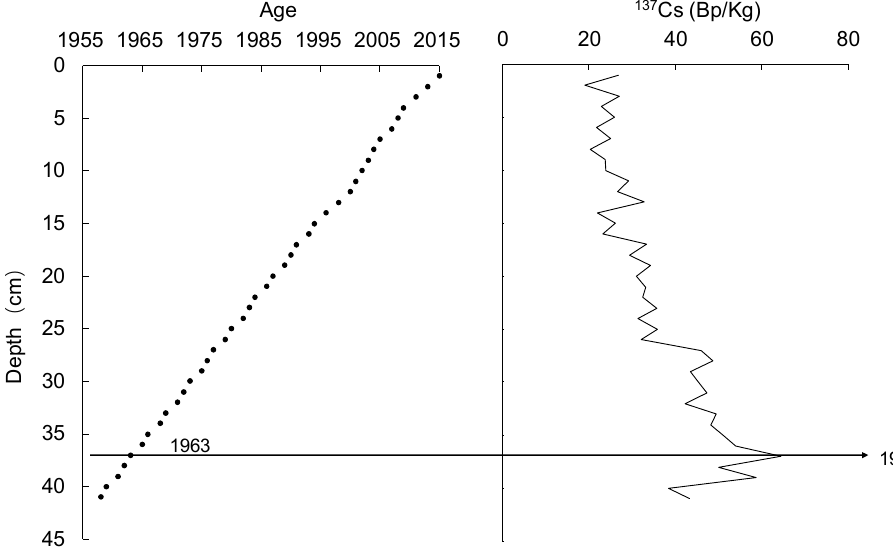
Figure 4. The age profiles determined by 210 Pb and 137 Cs.